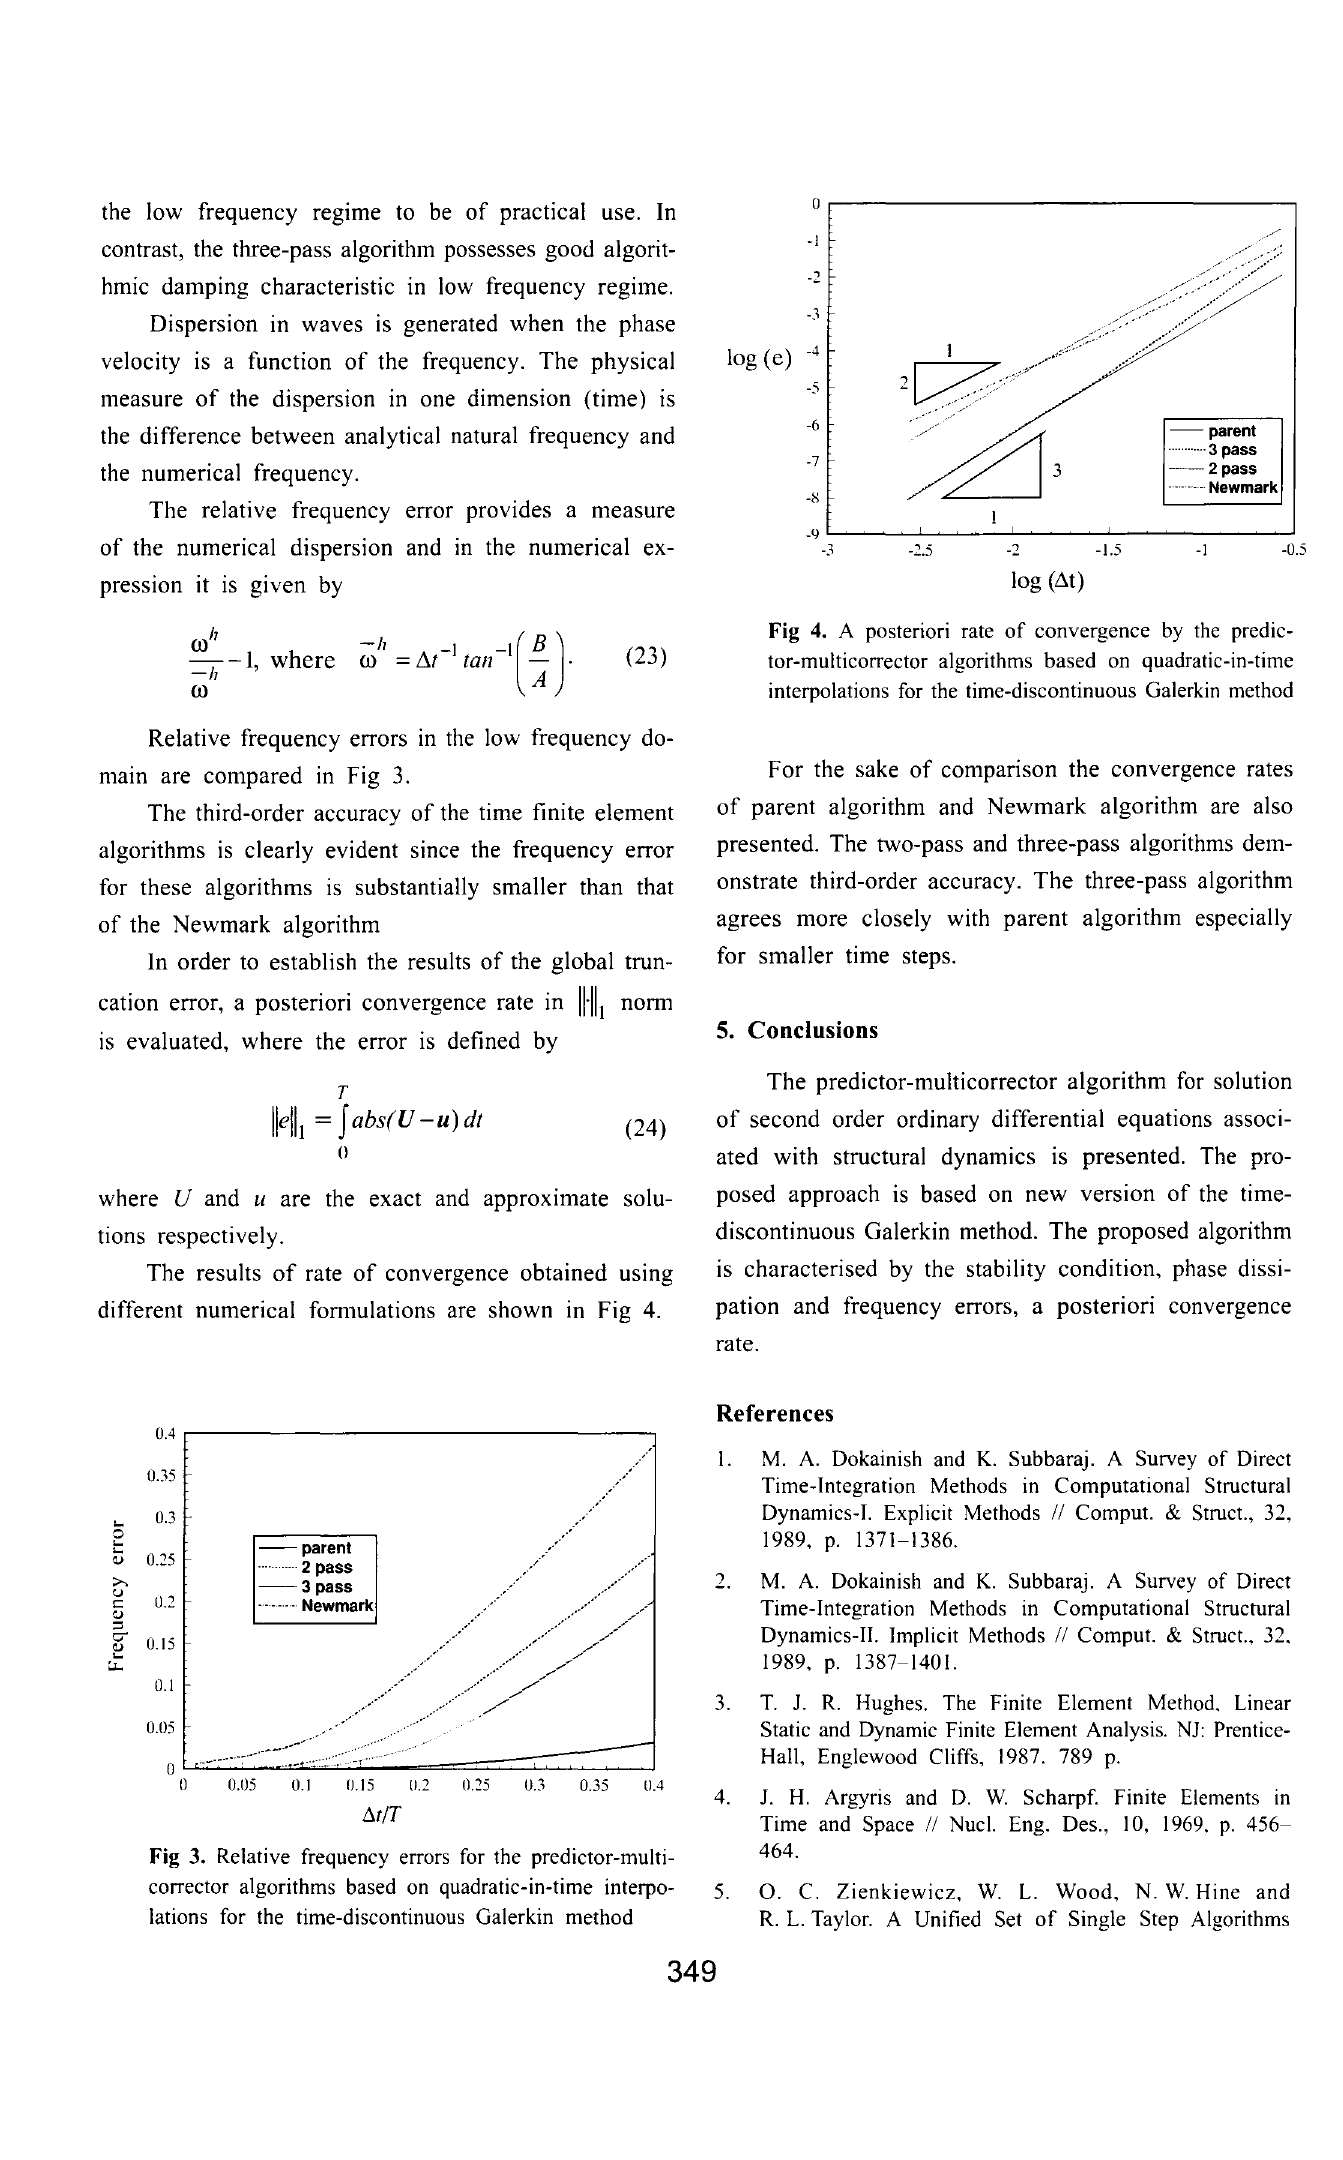
Fig 3. Relative frequency errors for the predictor-multi corrector algorithms based on quadratic-in-time interpo lations for the time-discontinuous Galerkin method